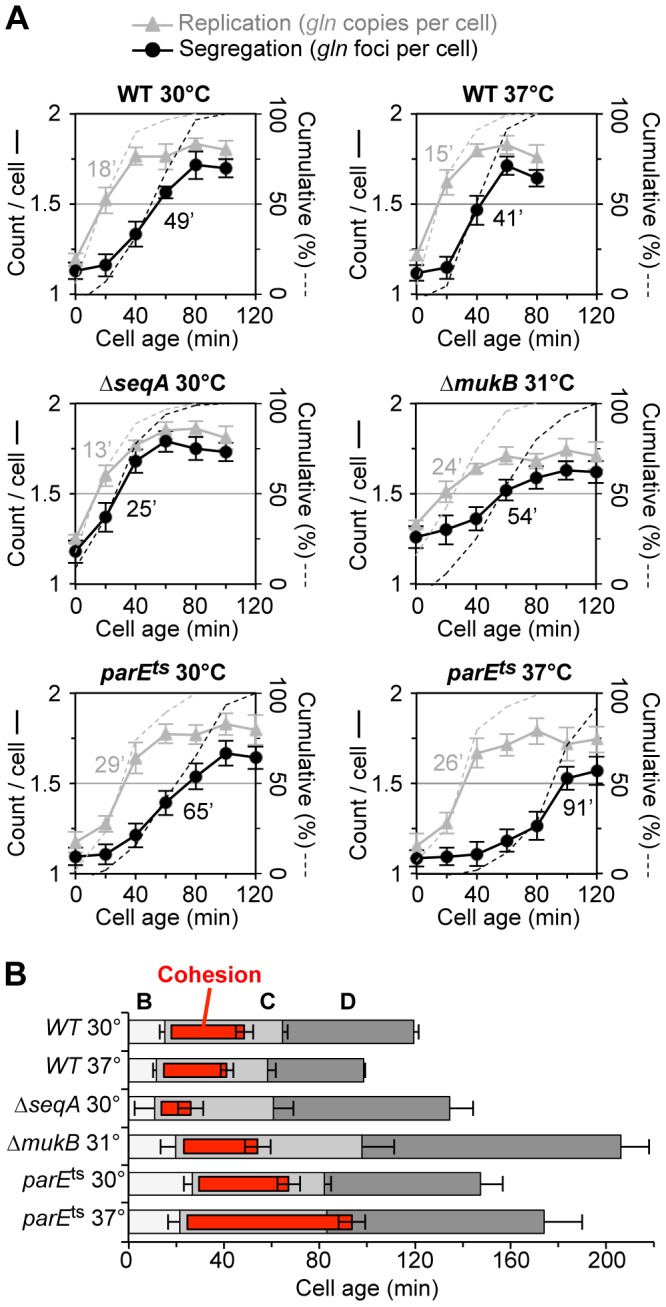
Synchronized cell analysis of ΔseqA, ΔmukB and parE10 strains.(A) Timing of replication and segregation of the gln locus. Cells were synchronized by baby machine in minimal alanine media at the indicated temperature and assayed for gln copy number (grey triangles) and number of TetR-YFP foci per cell (black circles) during the cell cycle. Values are means of two experiments ±1 SD. Dashed lines indicate the cumulative percentage of cells in the synchronized fraction that have replicated and segregated the gln locus (right ordinate), with times at 50% shown in minutes after birth. (B) Cell cycle diagrams are shown based on the timing of oriC, gln and ter duplication by qPCR (Materials and Methods). Doubling times in minimal alanine media were: WT/30°C, 119 min; WT/37°C, 98 min; ΔseqA/30°C, 134 min; ΔmukB/30°C, 211 min; parE10/30°C, 147 min; parE10/37°C, 174 min.